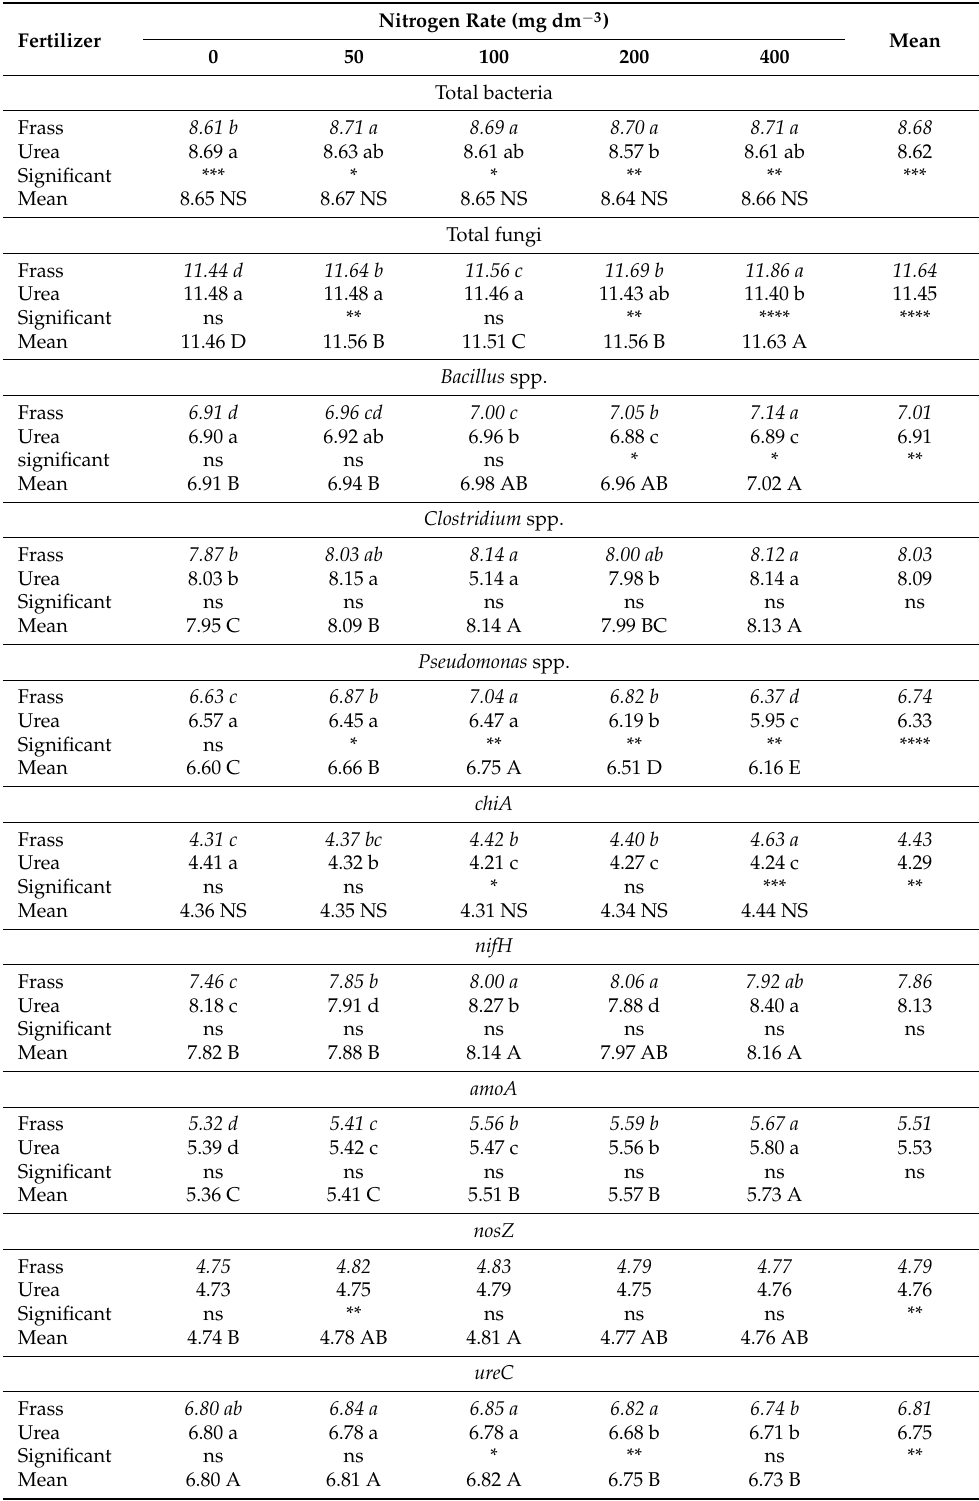
Table 3. Log-mean values of the microbiological properties of deacidified peat supplied with different fertilizers and nitrogen